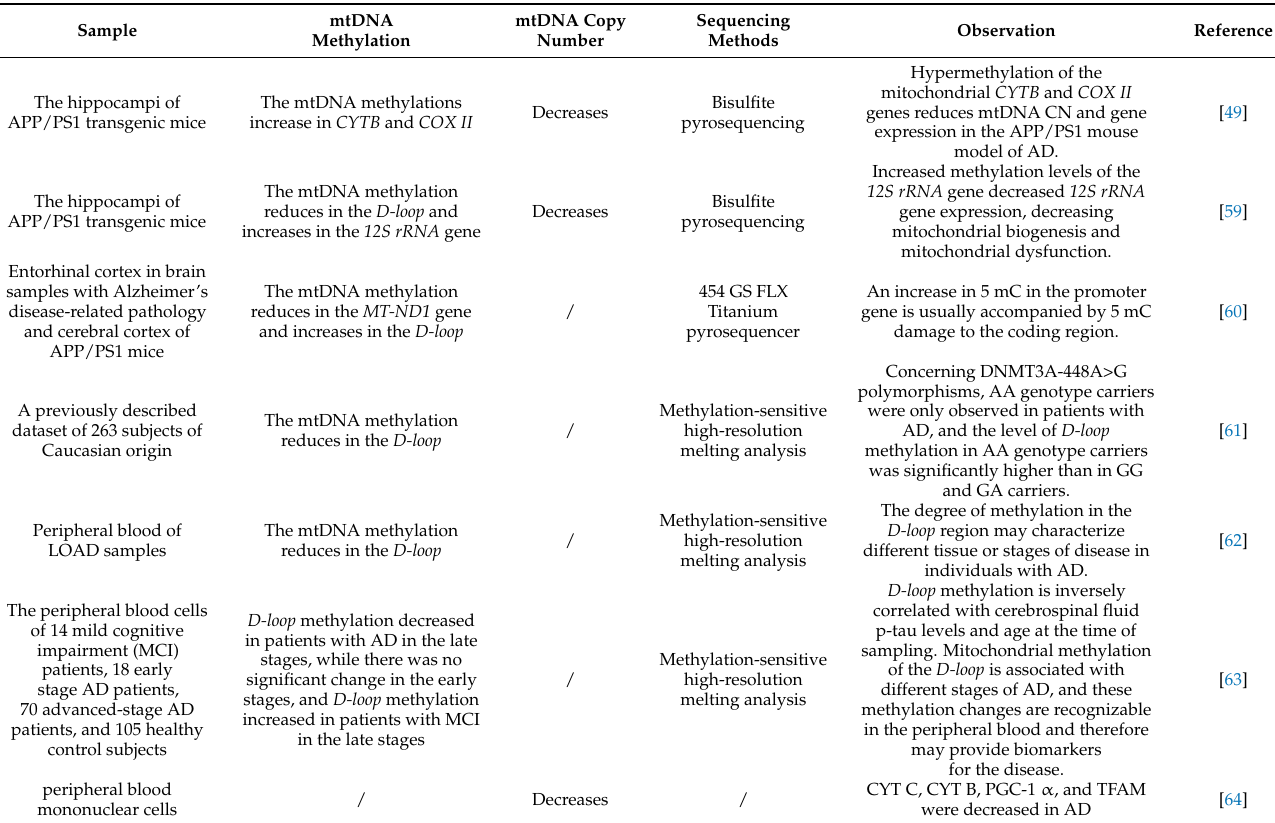
Table 1. mtDNA methylation detection in different AD samples.